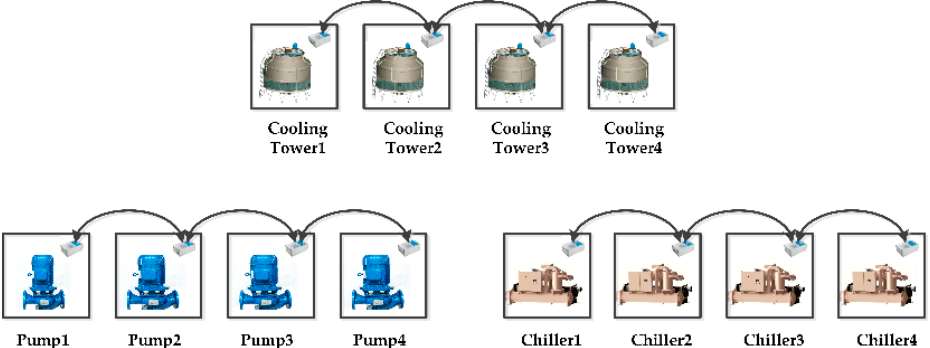
Figure 2. Structure of decentralized chiller plant control system.